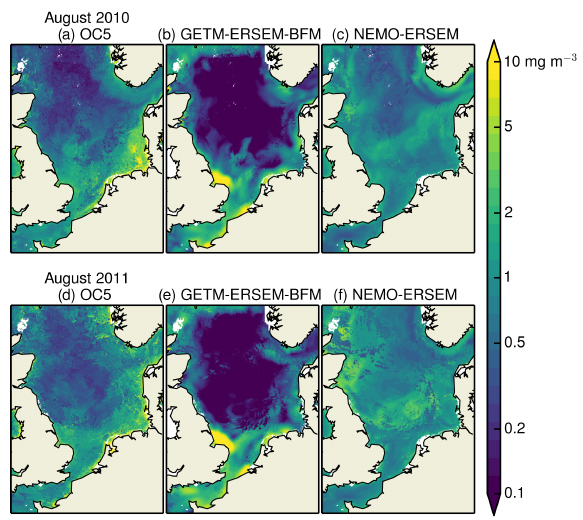
Figure 7. Composites of sea surface chlorophyll at ocean colour observation points for August 2010 (a–c) and August 2011 (d– f) : satellite observations (a, d) , GETM-ERSEM-BFM (b, e) , and NEMO-ERSEM (c, f) .